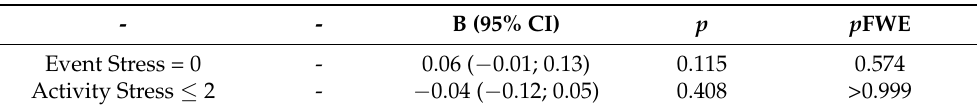
Table 5. Associations between pet presence and positive affect in a subsample of records for which reported stress-levels are low (combined